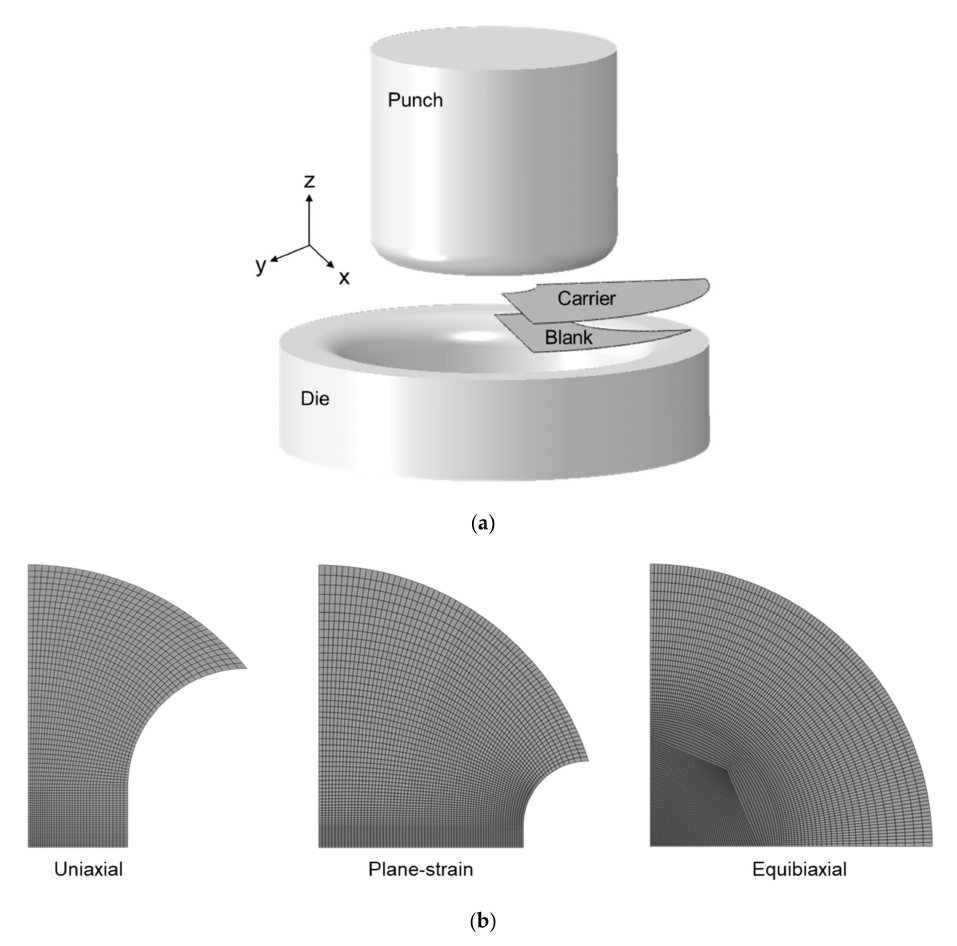
Figure 21. ( a ) FE model components for Marciniak simulation and ( b ) mesh design of blanks for uniaxial tension, plane-strain, and equibiaxial tension. Finer mesh is concentrated in the region where deformation is concentrated during